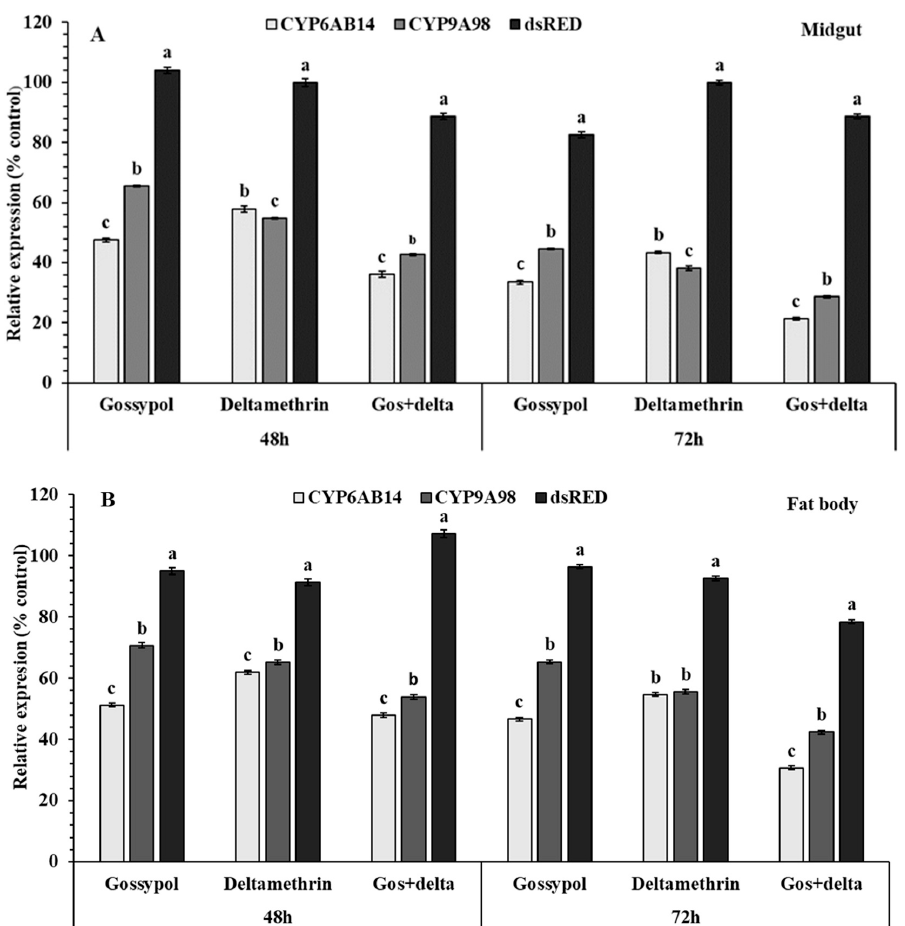
Figure 6. E ff ect of dsCYPAB14 and dsCYPA98 by droplet feeding on relative transcript levels in the midguts ( A ) and fat bodies ( B ) after 48 and 72 h ( A ) on the fourth instar S. exigua larvae. Following droplet-feeding with dsCYPAB14 and dsCYPA98 or dsRED served as a control for 24 h then the exposed larvae were transferred individually into 12-oriface tissue culture plate containing artificial diets supplemented with 0.1 % gossypol, LC 50 concentration of deltamethrin 0.887mg / L for 48 and 72 h or 0.1 % gossypol for 24 h followed by deltamethrin for 48 and 72 h. Data shown are means ± SE derived from three biological replicates. Di ff erent letters above bars indicate significant di ff erences ( p < 0.05) according to the Tukey HSD